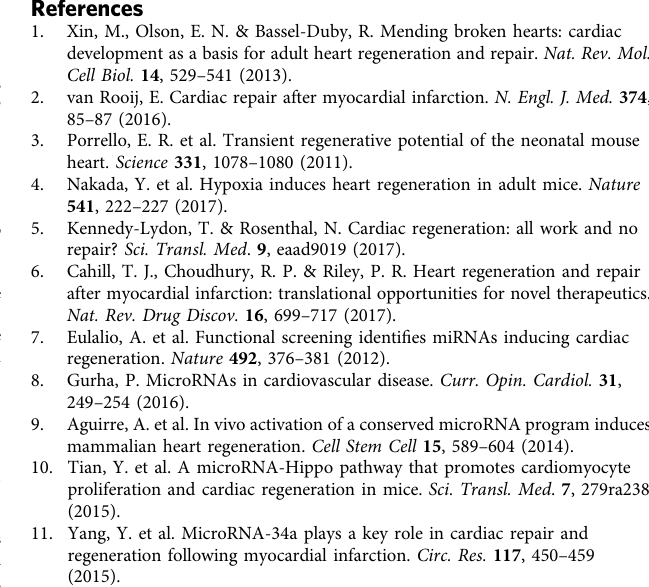
Fig. 7 Therapeutic potential of miR-19a/19b in treating infarcted hearts. a Schematic of tail-vein injection of RNALancerII-delivered miRNA mimics post myocardial infarction (MI). b qRT-PCR detection of miR-19a and miR-19b expression in the heart 6 h after injection post MI injury. n = 1 heart each group. c qRT-PCR detection of miR-19a and miR-19b expression in the heart at 24 h after injection with or without MI injury. n = 2 hearts each group. d , e Echocardiography analyses of cardiac function after tail-vein injection of miR-19a/19b and control mimic at different time points post MI. d FS%, left ventricular fractional shortening. e LVIDs LV internal dimension at end-systole. n = 3 – 10 mice. f Representative images of series of transverse heart sections after tail-vein injection of miR-19a/19b or control mimics post MI. Sirius red/Fast green collagen staining marks myocardium (green) and scar (red). g Quanti fi cation of the size of scar. n = 3 hearts. h Western blot analysis of protein levels of SOCS and STAT3 in the heart 24 h after tail-vein injection of miR-19a/19b or control mimics post MI. Statistical signi fi cance was calculated using Student ’ s t -test in d , f , and g and data are presented